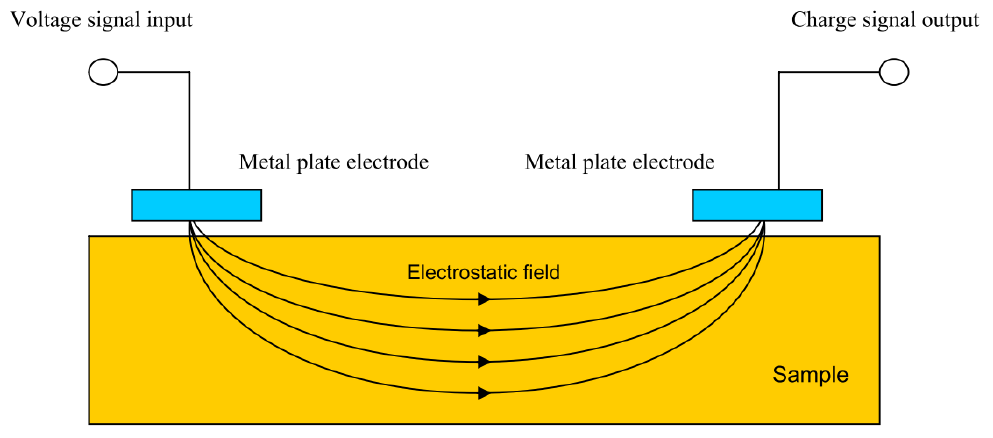
Figure 21. Capacitive sensing set up. (Reprinted from ref. [85]).